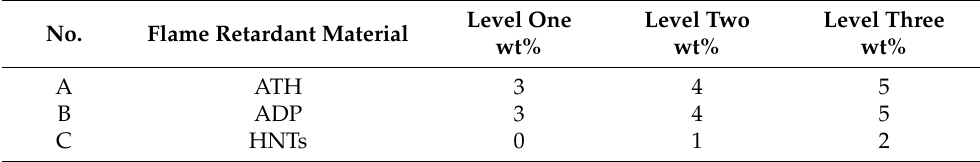
Table 2. Response surface three-factor three-level experimental design.